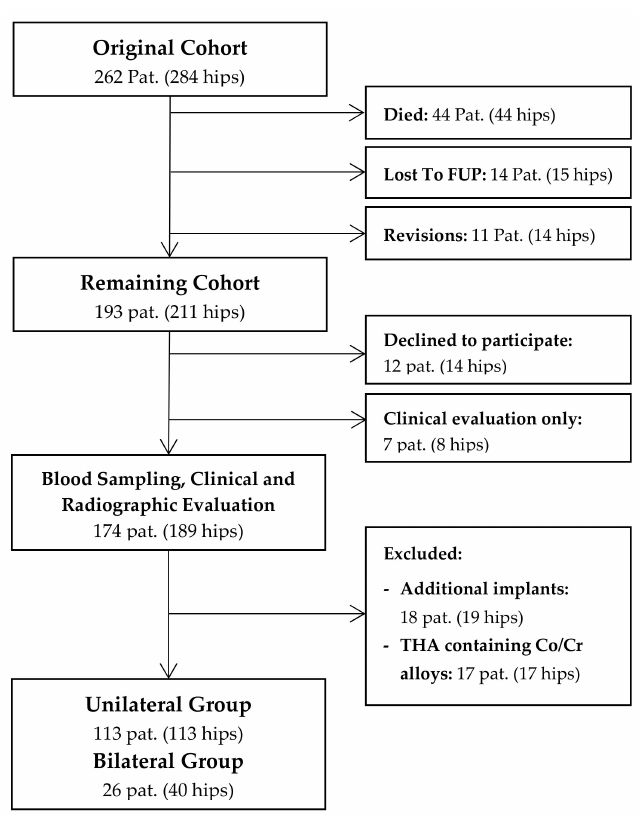
Figure 1. Flowchart summarizing clinical follow-up and patient selection for metal ion